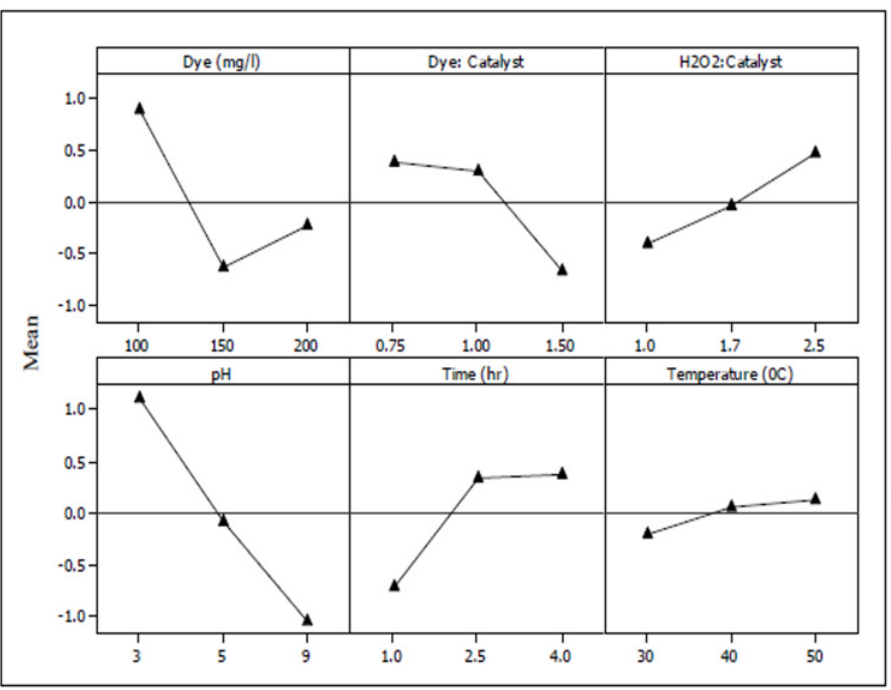
Fig 4. Mean TPCI plots with respect to parameter